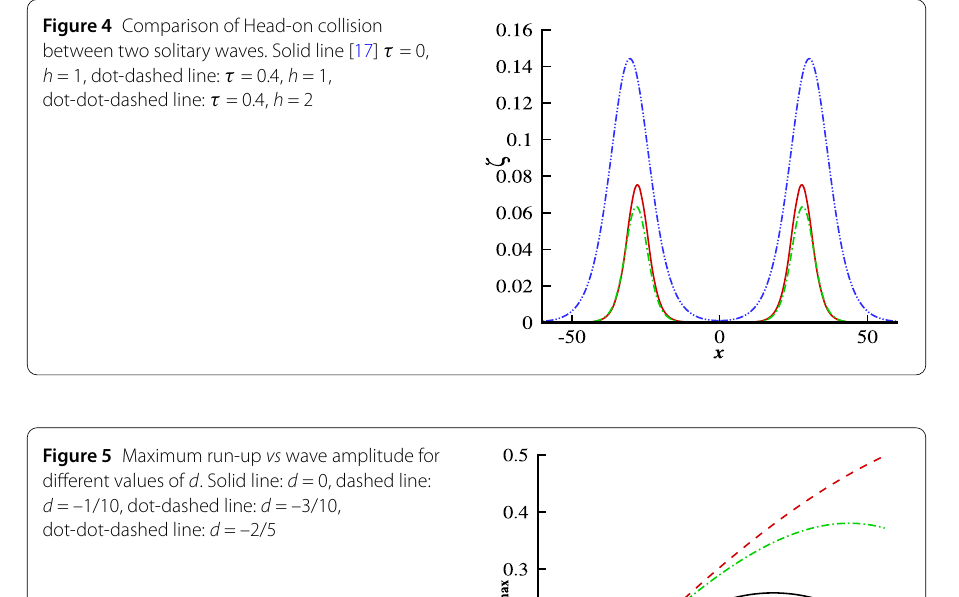
Figure 5 Maximum run-up vs wave amplitude for different values of d . Solid line: d = 0, dashed line: d = –1/10, dot-dashed line: d = –3/10, dot-dot-dashed line: d = –2/5